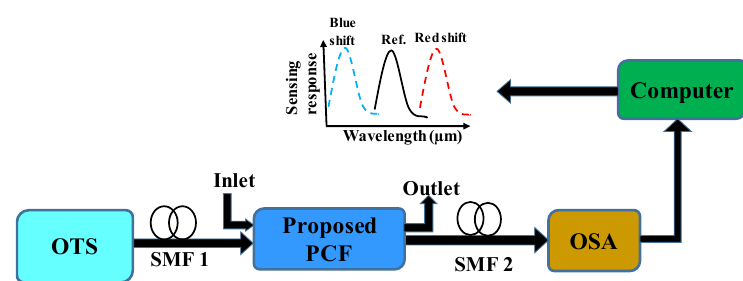
Figure 2. Schematic representation of the experimental setup of the proposed sensing platform. OSA, optical spectrum analyzer; OTS, optical tunable source; SMF, single-mode fiber.